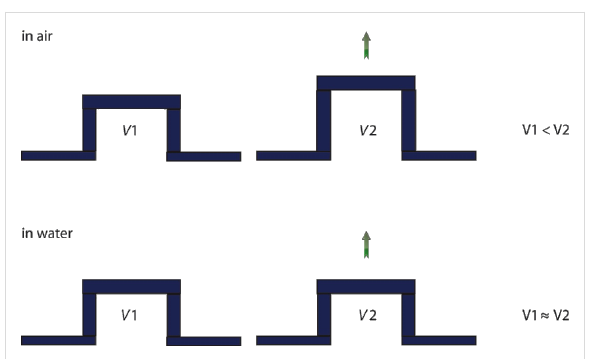
Figure 8: In air the volume of the cavity of suction cups increases. Due to the incompressibility of water the volume of suction cups stays the same while working under water.